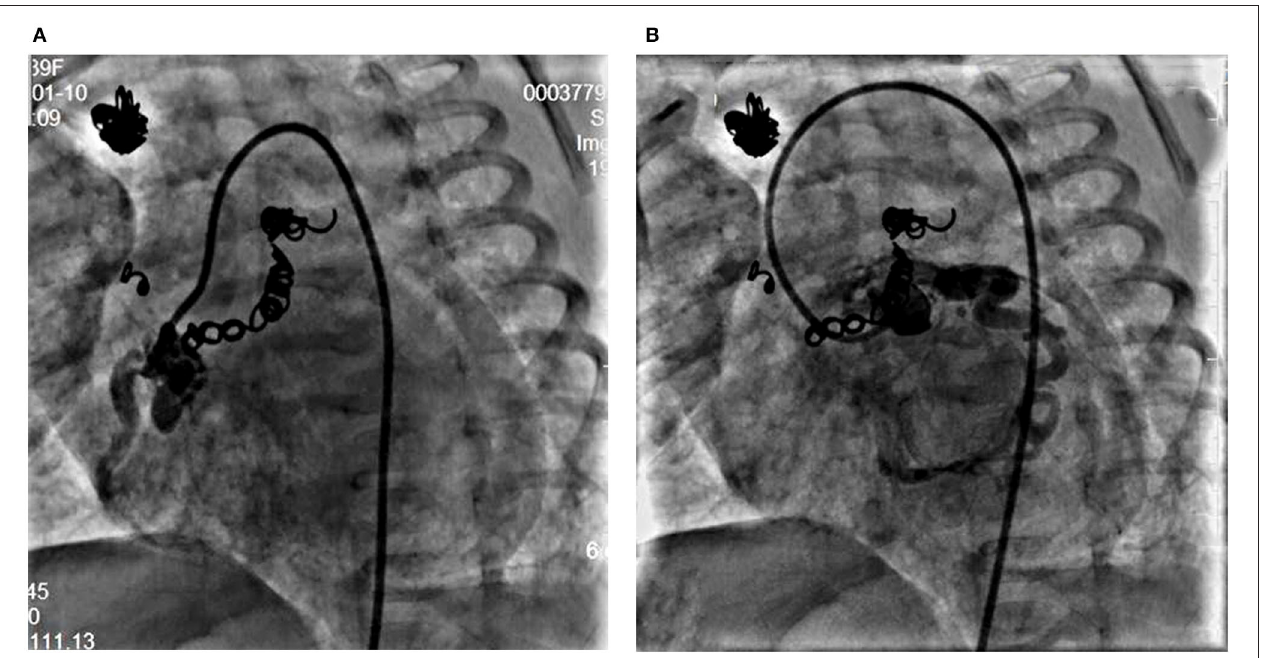
FIGURE 2 | Right coronary angiogram from left anterior oblique 45 ◦ view shows the dilated right coronary artery fistula with a proximal fistula to the right atrium and a distal fistula into the right ventricle (A) . Left coronary angiogram shows a fistula from the left anterior descending coronary artery to the right atrium (B)